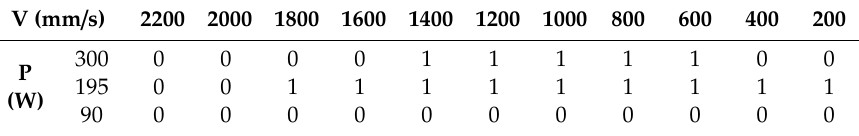
Figure 4. The values of four evaluation indicators: ( a ) the average width, ( b ) the average height, ( c ) the ratio of standard deviation of width to the average width, and ( d ) the ratio of standard deviation of height to the average height. Table 1. The classification results of the tracks which are used as the target output of the NN model. As tracks of type IV had the potential to form parts with excellent performance, the combinations of laser power and scan speed at which they formed were marked as “1”, while other combinations as